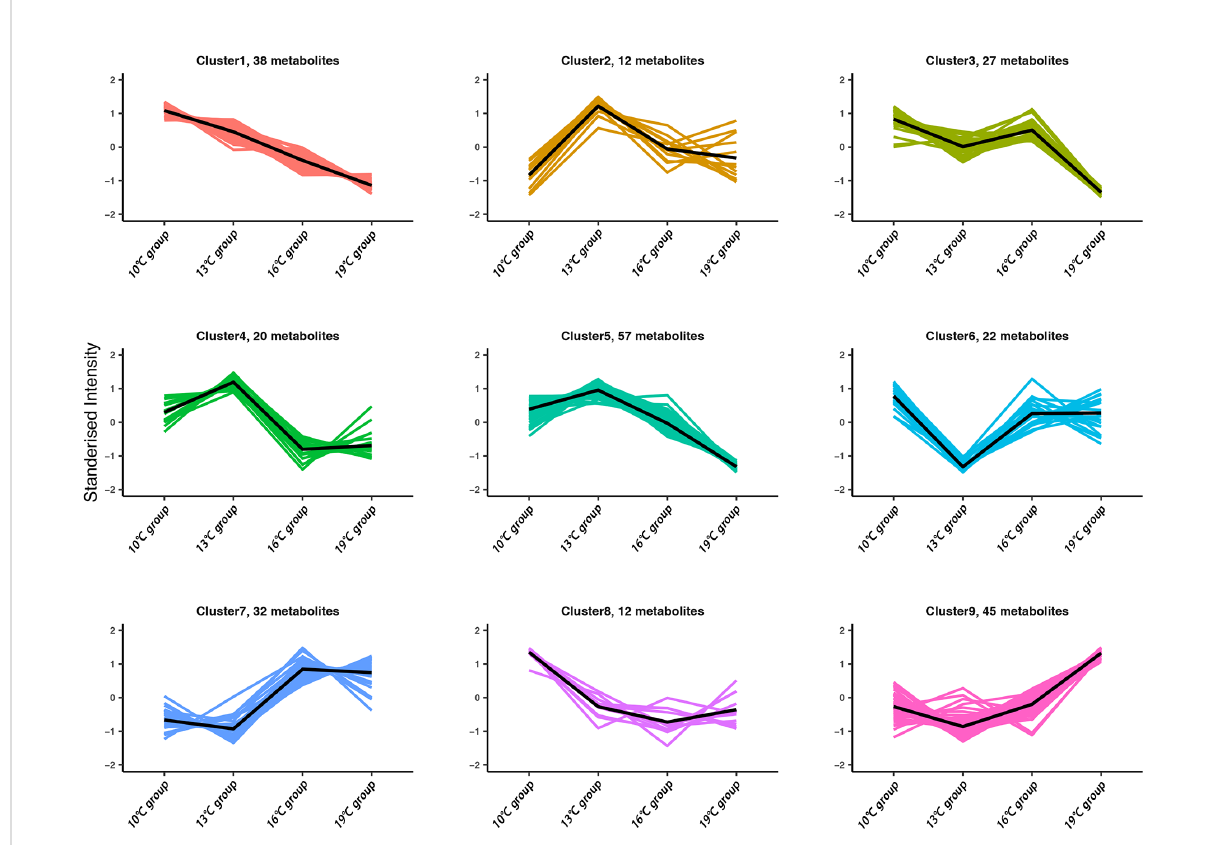
FIGURE 4 Dynamic change of differential lipids with increasing